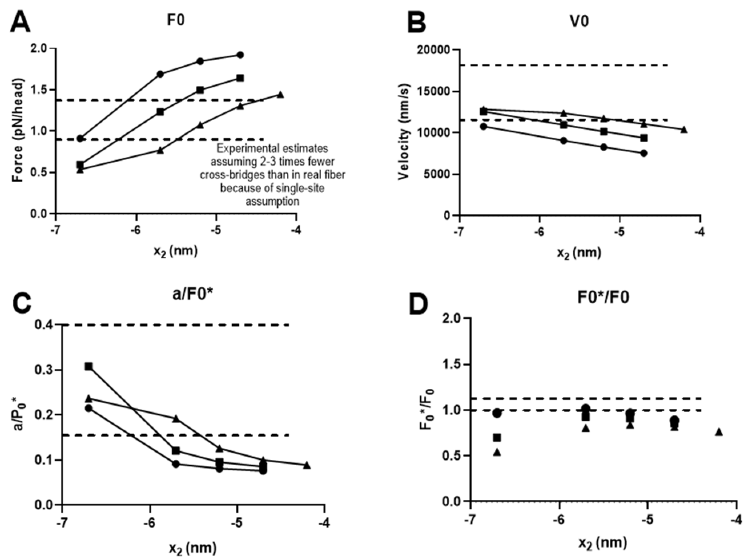
Figure 3. Effects of changes in parameter value x 2 at three different values of Δ G AMDH-AM/AMD (at constant Δ G AMDL-AMDH + Δ G AMDH-AM/AMD = 16 k B T) on FV parameters and quantitative effects of 1–2 mM amrinone on V 0 and F 0 . ( A ) Variations in simulated values (pN/(all cross-bridges; N) ) of isometric force ( F 0 ) vs. x 2 with Δ G AMDH-AMD of 2 k B T (black circles), 4 k B T (black squares), and 6 k B T (black triangles). The same symbols are used in the other panels. Normal range indicated by dashed lines corrected for the simplifying assumption in the model of one myosin binding site per actin target zone (at 36 nm interval) along the thin filament. The calculations of the normal range assumed 294 myosin heads per thick filament associated a cross-sectional area of 1.6 10 − 15 m 2 and an isometric force per myofibrillar cross-sectional area of 450–500 kPa [58,59]. ( B ). Variations in simulated values of V 0 vs. x 2 . Normal range indicated by dashed lines (cf. [8]). Same coding by symbols as in A. ( C ) Variations in simulated values of the ratio a/F 0 * where vs. x 2 where a is derived by a fit to Hill’s hyperbolic equation (see Materials and Methods) limited to force values below 80% of F 0 . The parameter F 0 * is an estimate of F 0 obtained by extrapolating the Hill equation to zero velocity. Normal range indicated by dashed lines. Same coding by symbols as in A. ( D ) Variations in simulated values of the ratio F 0 */F 0 that is one estimate of the degree of deviation in the FV data from a hyperbola. Normal range indicated by dashed lines. Same coding by symbols as in A. Note that the ratio is highly sensitive to minor changes in the shape of the FV relationship. E. Simulated effects of amrinone (see text and below) on F 0 and V 0 with similar symbol coding as in A, but open symbols for F 0 and filled symbols for V 0 . F. Simulated FV data after modifying x 2 from − 6.7 to − 5.2 nm, Δ G AMDL-AMDH from 14 to 12 k B T, and Δ G AMDH-AM/AMD from 2 to 4 k B T but keeping all other model parameters at standard values (Tables 1 and 2) for physiological conditions (black). Effect of amrinone (red) simulated by changing Δ G AMDH-AM/AMD to 1 k B T. Experimental data (purple) the same as in Figure 2. Most simply, the steady-state FV relationship with a higher attachment rate constant during shortening can be simulated by assuming a higher cross-bridge attachment rate at all loads. An increase in k on ’ from 130 to 325 s − 1 could account for the high power output during shortening against intermediate loads rather well, with only minimal effects on the steady-state isometric force (Figure 4A). However, the experimentally observed deviation from a hyperbola of the FV relationship at high loads is not very well-predicted with this set of parameter values. The non-hyperbolic deviation has previously been shown to reflect the positions along the x-axis (cf. Figure 1B) of the free energy minima of the different cross- bridge states [40,60] as well as the level of these free energy minima relative to each other [40]. Here, we modified the positions slightly from those used in Figure 3F and Figure 4A in order to improve the predictions. This can be justified within the bottom-up modeling framework due to uncertainties of up to 1 nm [6]. First, we tested to increase the values of x 1 and x 11 (Figures 4A–D), thereby increasing the total stroke following attachment from about 7 to 8 nm, well within current estimates (reviewed in [10]). As predicted based on